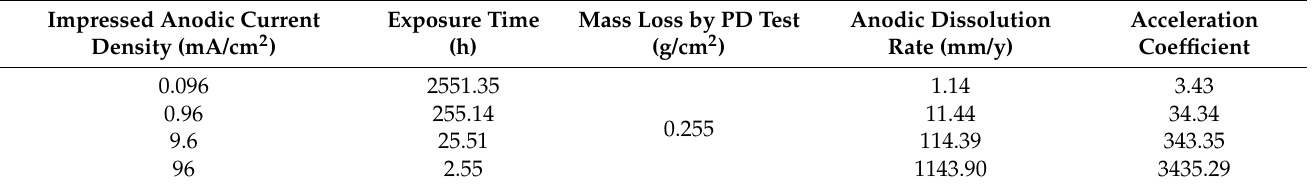
Table 4. Experimental conditions and calculated